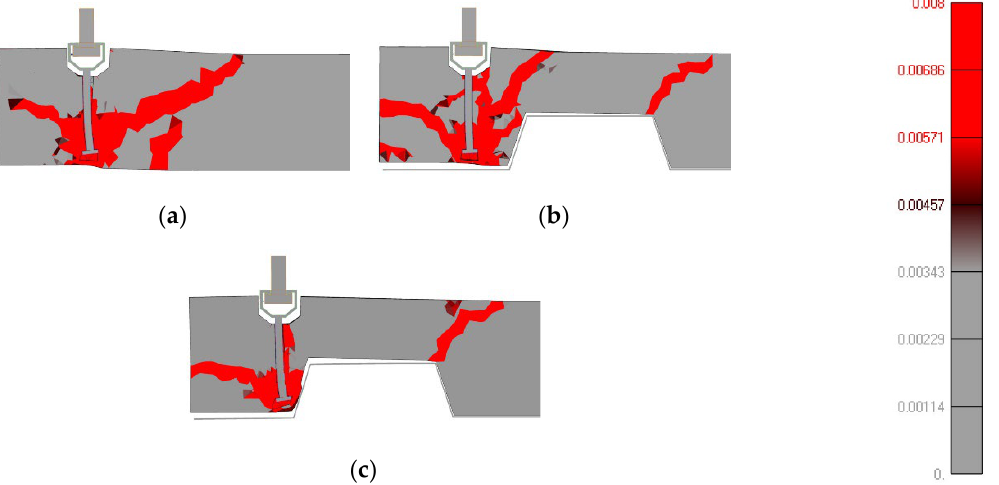
Figure 9. Post- peak breakout patterns ( s ection through the anchor for h ef = 120 mm) for: ( a ) plain concrete slab; ( b ) composite slab— d w = 45 mm; and ( c ) composite slab— d w = 15 mm.